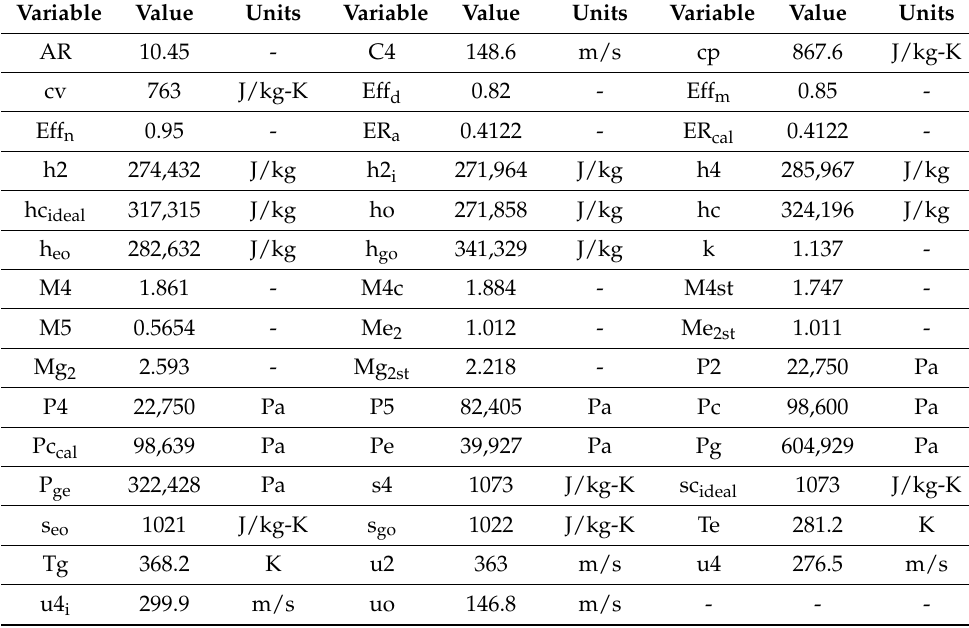
Table A4. Result from the developed EES model based on 0-D model of Chen